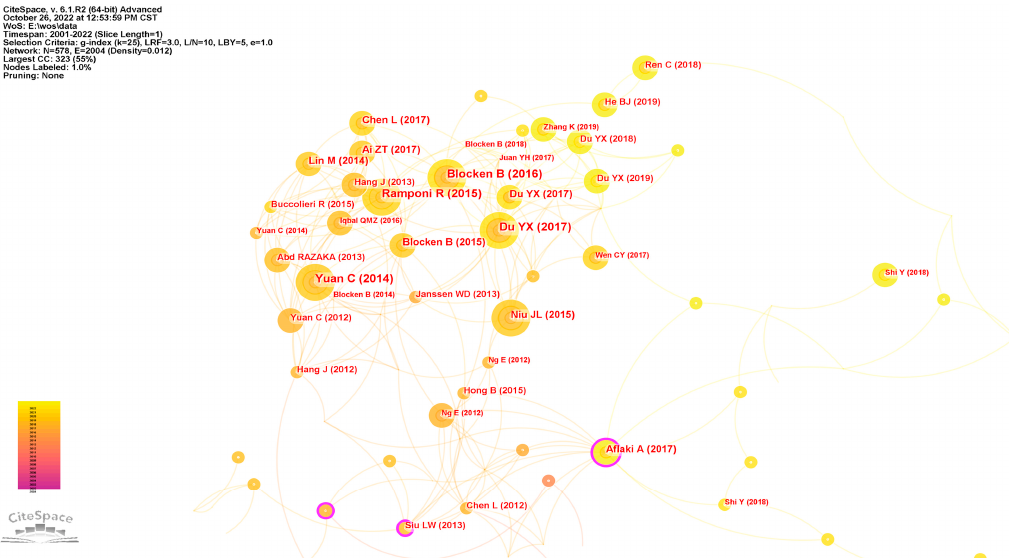
Figure 8 . Knowledg e map of highly cited articles in high-density city research from 2001 to 2022. Figure 8. Knowledge map of highly cited articles in high-density city research from 2001 to Table 7 . Most-cited articles on high-density city research from 2001 to 2022.